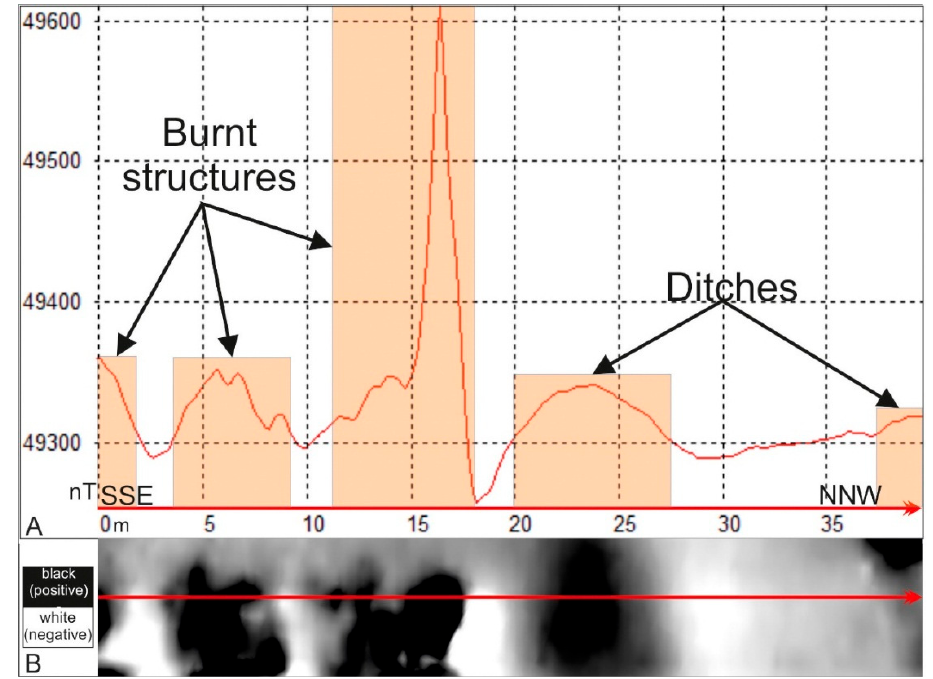
Figure 12. Magnetic profile corresponding to the red line in Figure 11A. Both in the profile ( A ), and in the plan view representation ( B ) the strong intensity of anomalies generated by three dwellings and the two large parallel ditches are conspicuous.